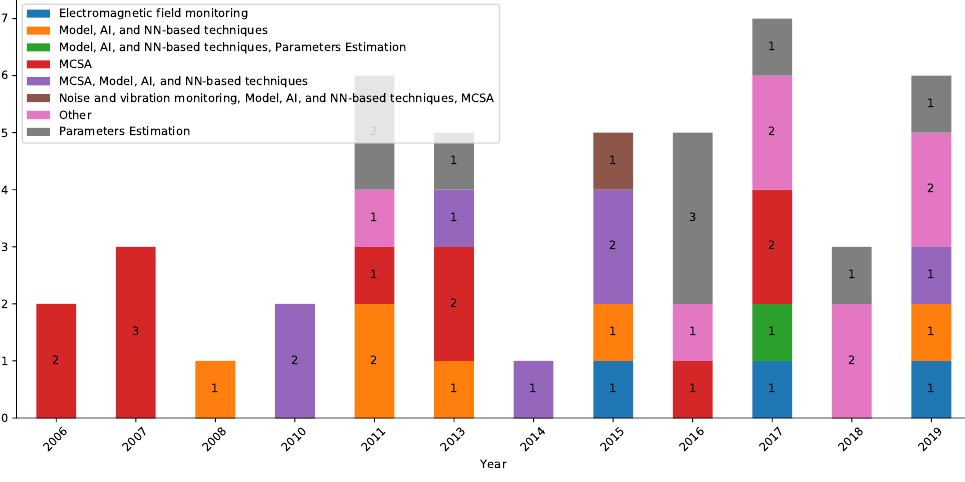
Figure 4. Distribution of the used techniques over the publication